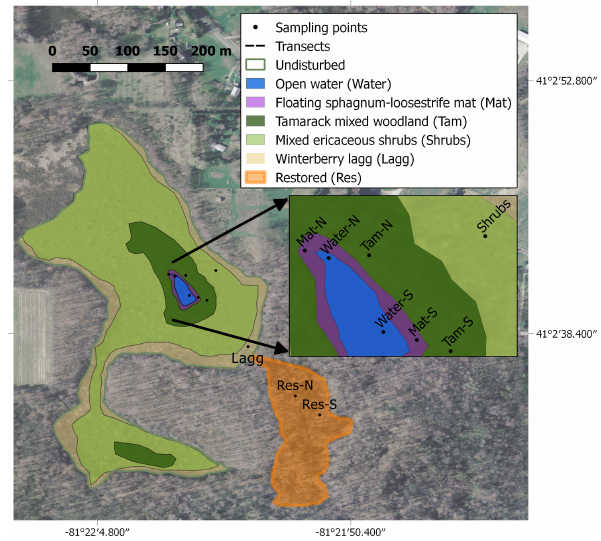
Figure 1. Map of the study site showing the different hydro- biological zones and the sampling locations. The map was cre- ated with QGIS, and the image was downloaded from the Ohio Geographically Referenced Information Program (OGRIP) (http: //gis5.oit.ohio.gov/geodatadownload/, last access: 2 February 2018, image reference number: N2280505 and